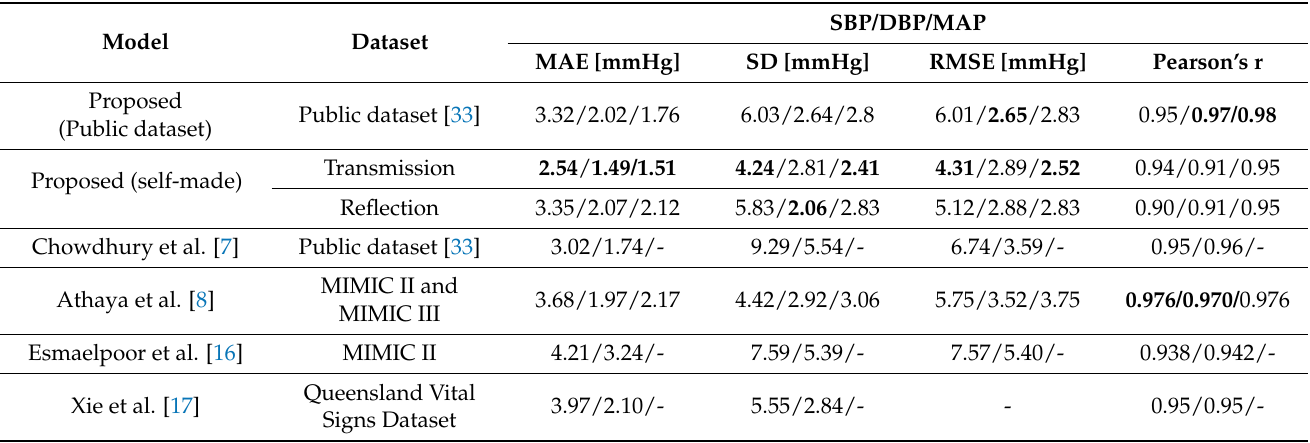
Table 14. Performance comparisons with related